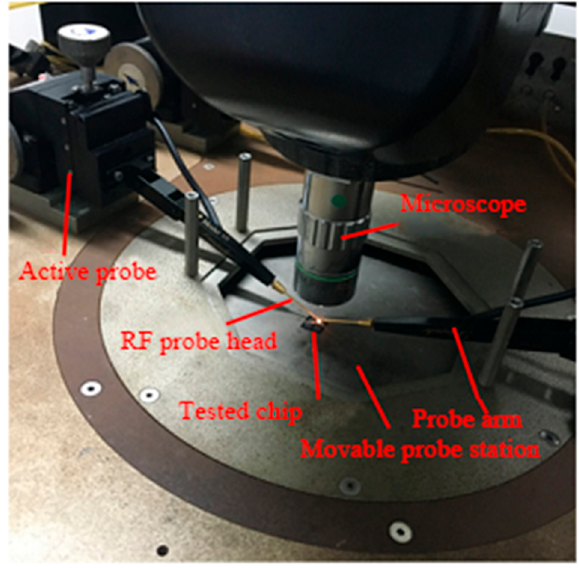
Figure 7. Resonator testing platform.